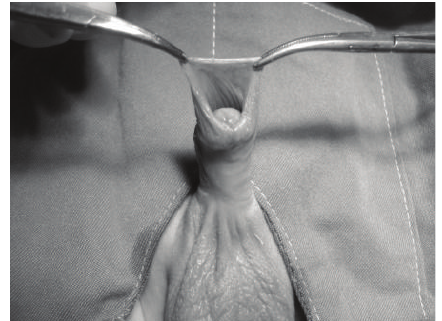
Figure 1: Hooded prepuce.